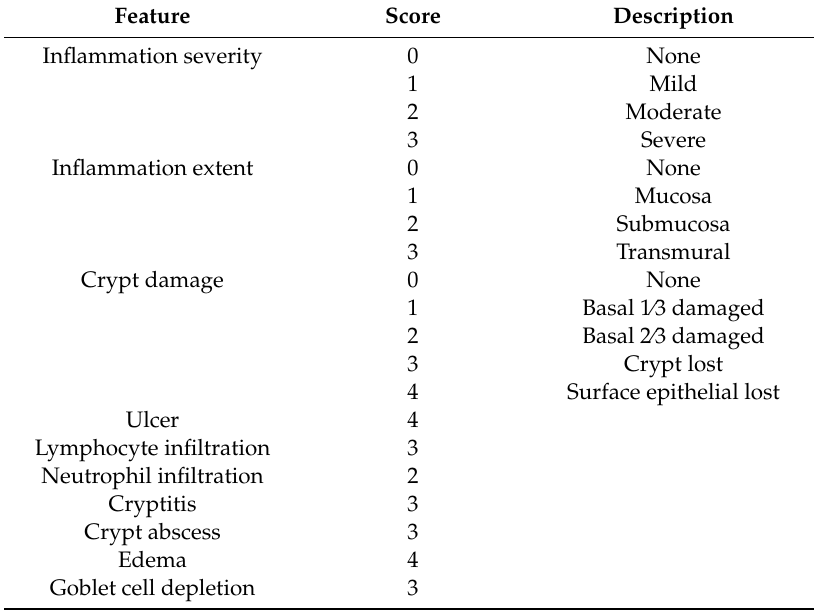
Table 1. Histological scoring of the severity of the